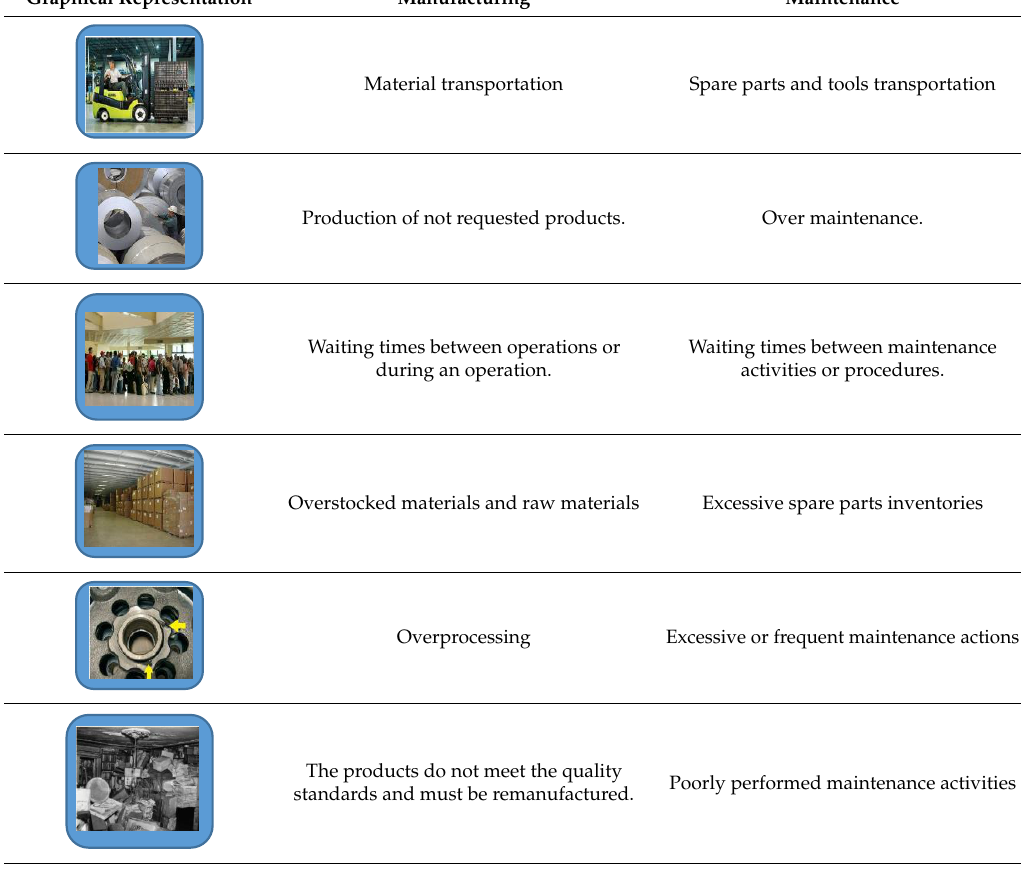
Table 1. Correspondence between the sources of waste in lean manufacturing and maintenance. Graphical Representation